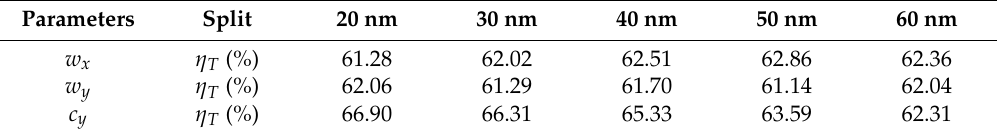
Table 1. Total efficiency η T at different split sizes.